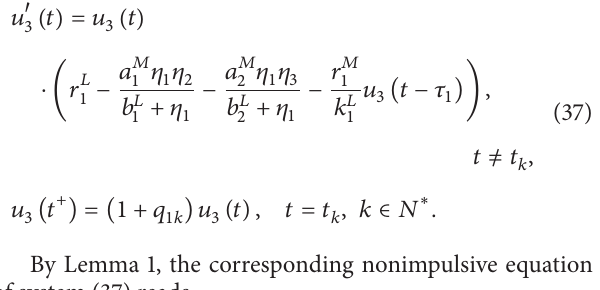
hold; then for any solution of system (1) there exist 𝑇 > 𝑇 0 and